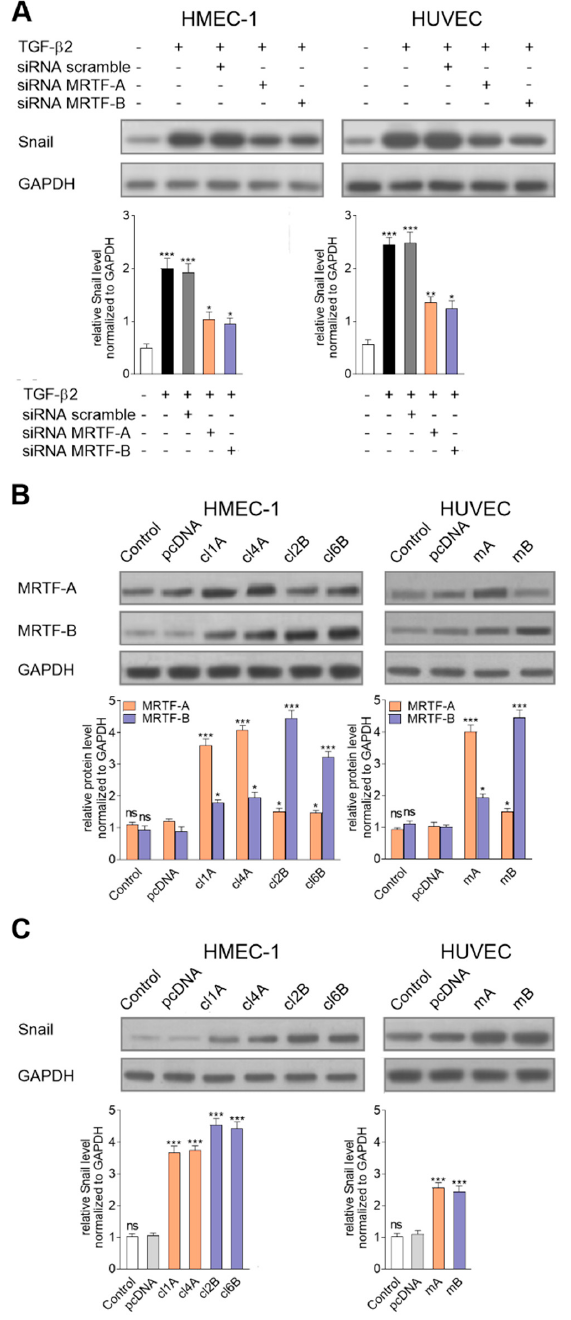
Figure 3. Regulation of the MRTFs caused modulation of snail expression. ( A ) Effect of MRTF-A or MRTF-B downregulation using siRNA treatment on the Snail level in TGF- β 2-induced cells was analyzed by a Western blot assay. Subsequently, ( B ) MRTF-A (Clone 1—cl1A; Clone 4—cl4A) or MRTF-B (Clone 2—cl2B; Clone 6—cl6B) stably transfected HMEC-1 cells and MRTF-A (mA) or MRTF-B (mB) transiently transfected HUVECs were analyzed. Additionally, the control of the cell transfection clones with only an empty vector (pcDNA) was tested. ( C ) Next, a similar analysis of the Snail level was done. The protein level in each sample was determined using scan densitometry in compared to GAPDH (as the normalization). Blots are representative of three independent experiments. The results are presented as the means ± SD ( N ≥ 3); * p < 0.05, ** p < 0.01, *** p < 0.001.